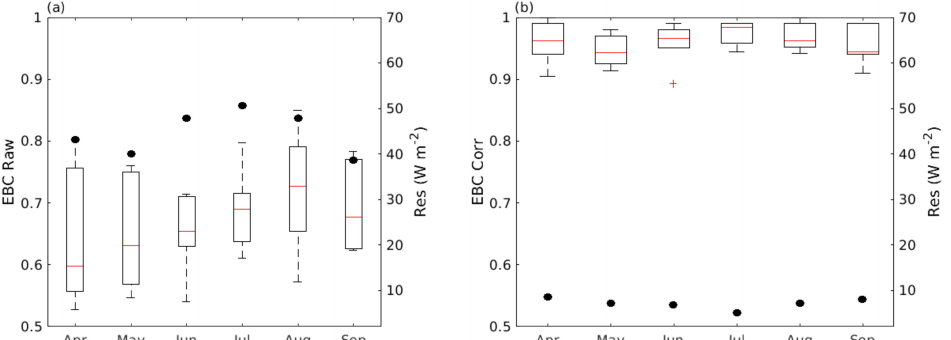
Figure 3. Comparison of the energy balance closure (box plot) and the mean residual energy in W m − 2 (black circle) for ( a ) the raw eddy covariance fluxes and ( b ) the corrected fluxes from the Bowen ratio